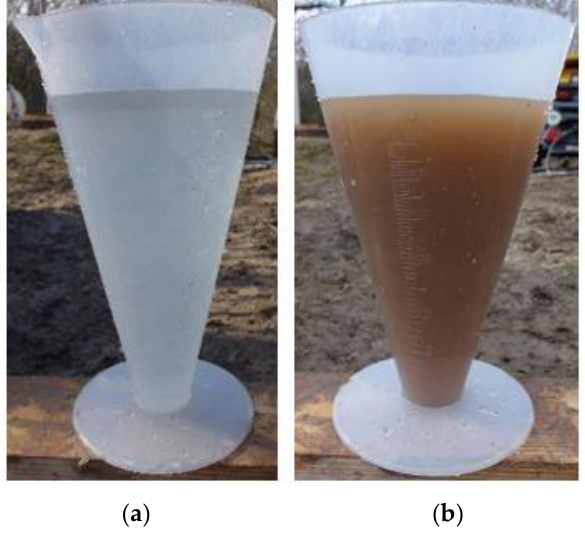
Figure 9. Comparison of turbidity in raw water before ( a ) and after the start ( b ) of ultrasound rehabilitation.